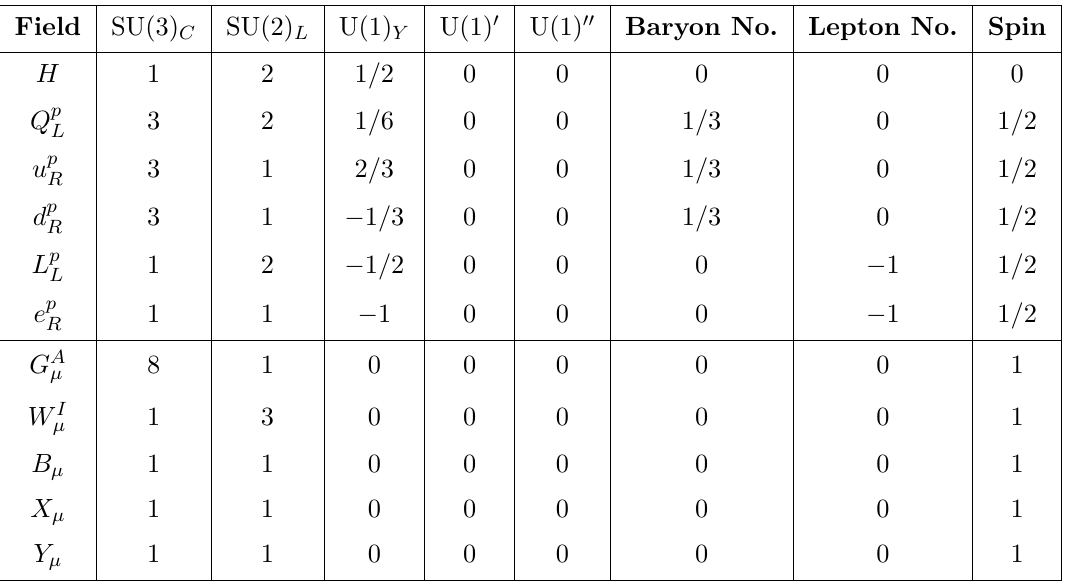
Table 24 . SM extended by two abelian gauge symmetries: quantum numbers of the fields.